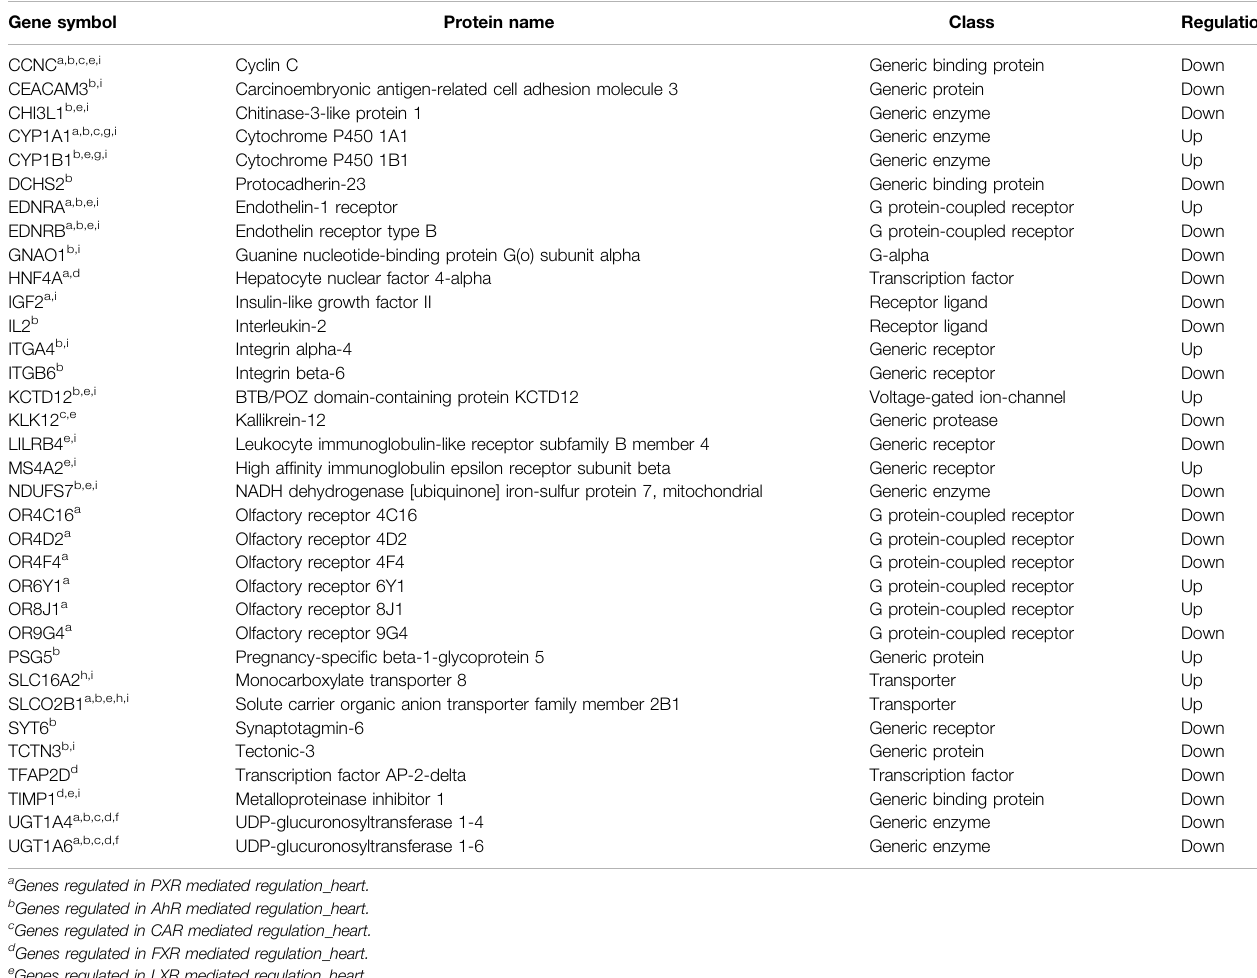
TABLE 1 | Genes of statistically signi fi cant ( p < 0.05) drug and xenobiotic metabolism pathways regulated by 4 h Wnt5A treatment in HCAEC. Data are from 3 independent array experiments. Gene